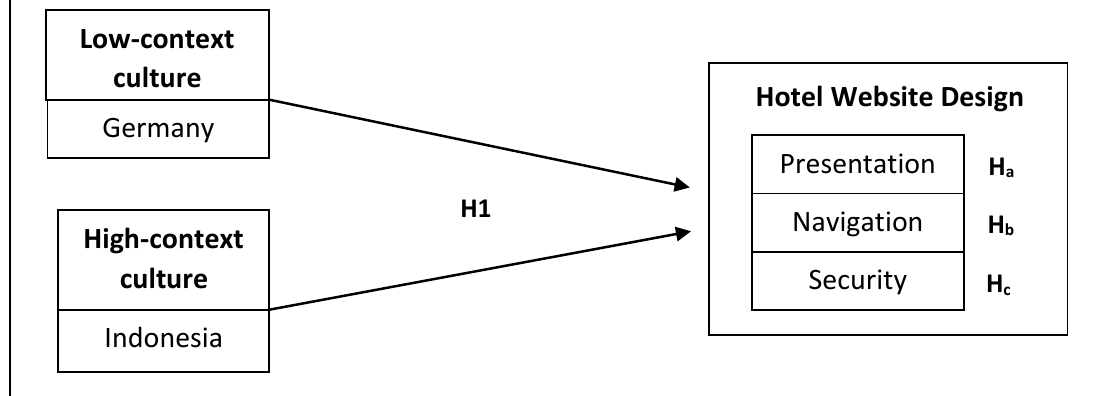
Figure 1. Conceptual